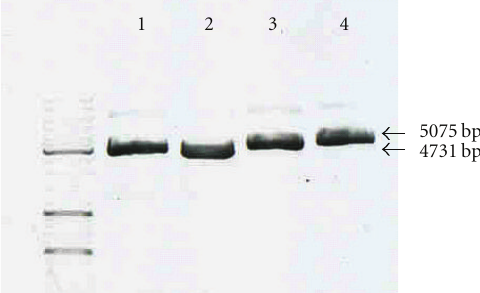
Figure 1: Electrophoretic analysis of the plasmids carrying the wild type (Wt) and mutant (Mut) alleles of the PSEN-1 gene and original, commercially available plasmids: (1) pEGFP-C1 (4731 bp), (2) pDsRed-N1 (4689 bp) (3) pEGFP-Wt-PSEN1(400) (5075 bp), (4) pEGFP-Mut-PSEN1(400) (5075 bp) (0.5% agarose gel).